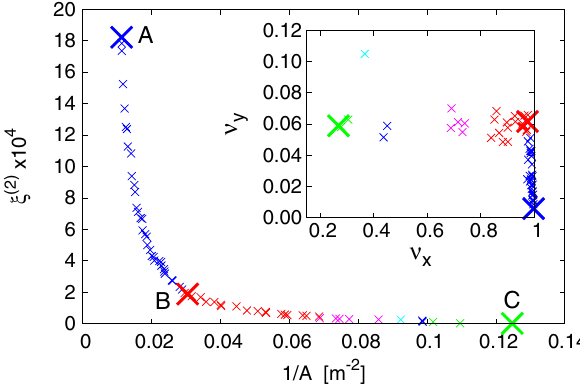
FIG. 17. Pareto front after 24 generations of 64 individuals. The large (cid:5) ’s denote representative points A, B, and